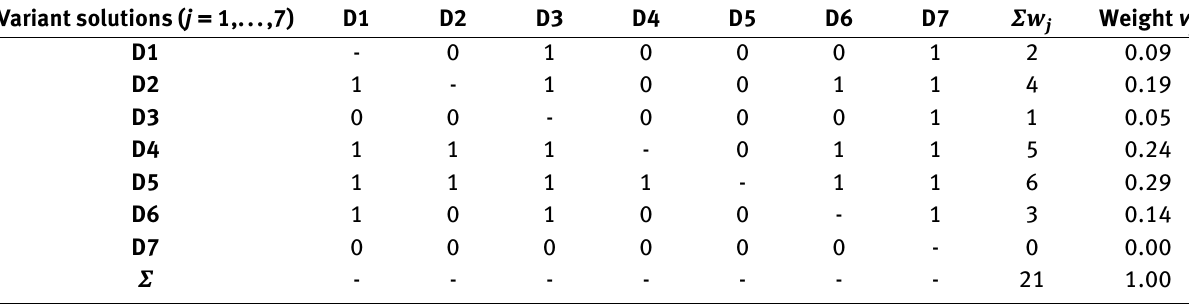
Table 5: Standardization of variant solutions weights’ according to criterion K3 [author]. Variant solutions ( j = 1,...,7)